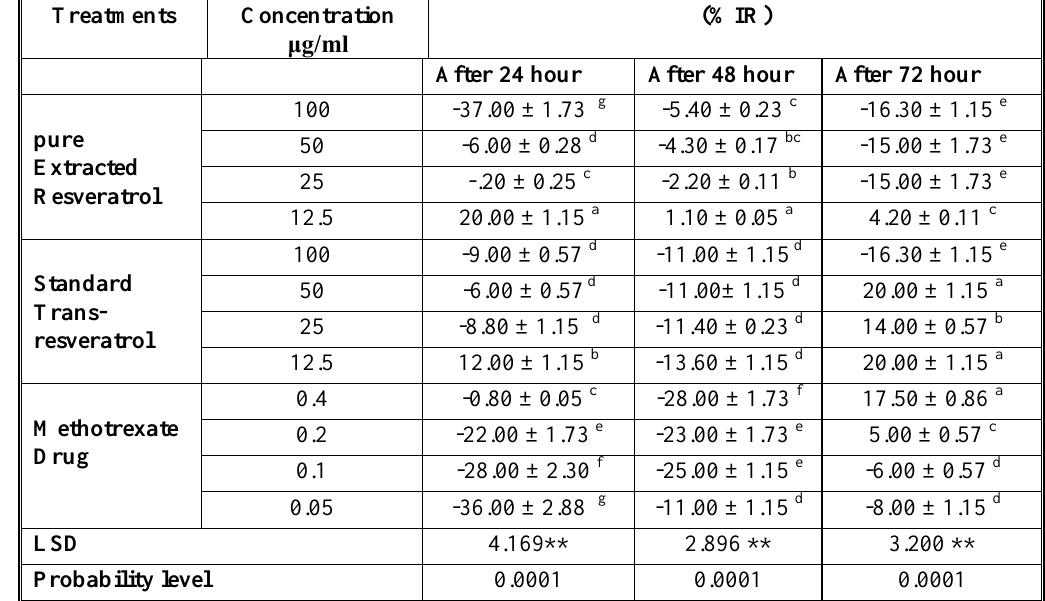
Table 1: The cytotoxic effect as inhibition rate percent (%IR) of extracted pure resveratrol and trans- resveratrol standard and methotrexate drug on AMN-3 at (24,48 and 72) hours of exposure . SE= Standard Error